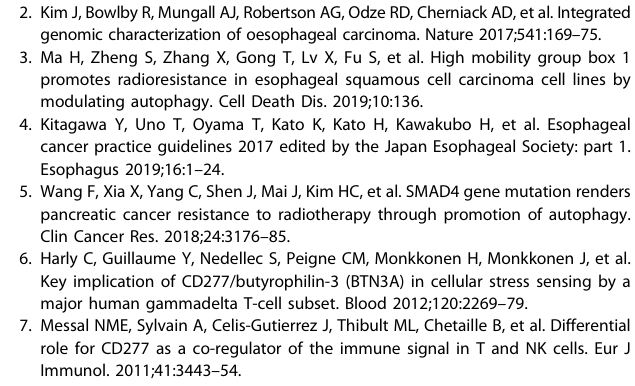
Fig. 8 Working model of BTN3A1 the mechanism by which promotes radioresistance by modulating autophagy in ESCC cells. Radiation increased BTN3A1 expression through a pathway mediated by HIF-1 α . BTN3A1 regulated the expression of ULK1 and promoted its phosphorylation to subsequently initiate